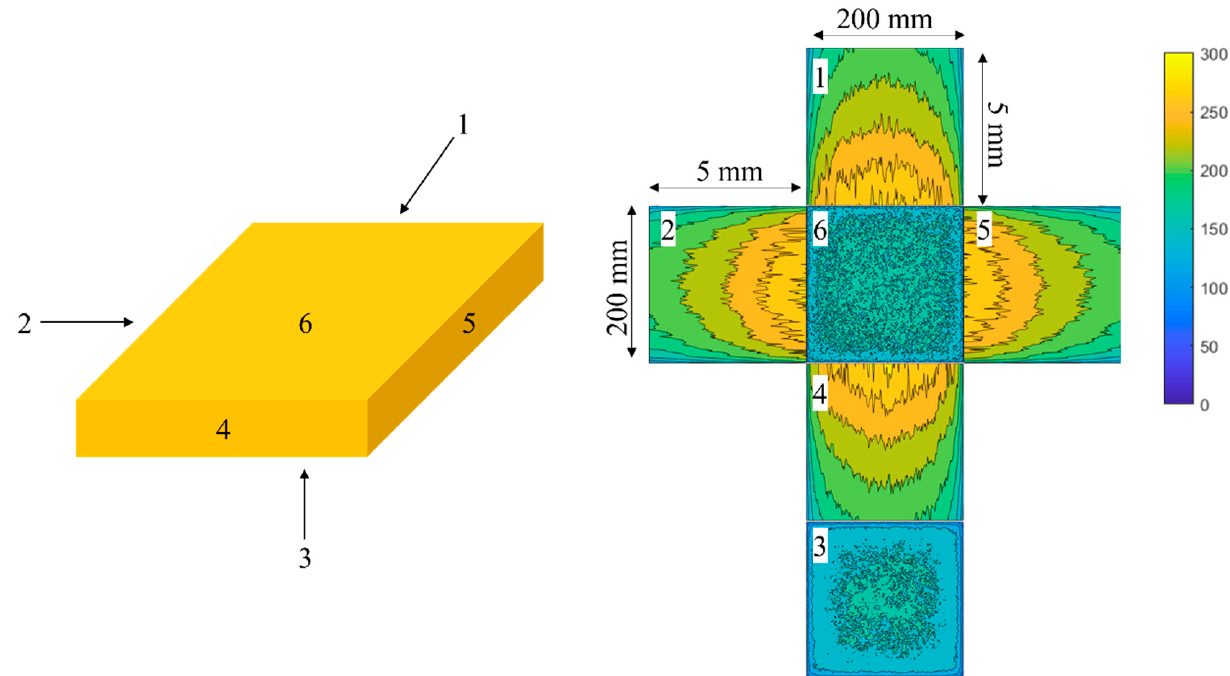
Figure 4. Surface heat map of the LSC (color bars with the unit of W m − 2 ).